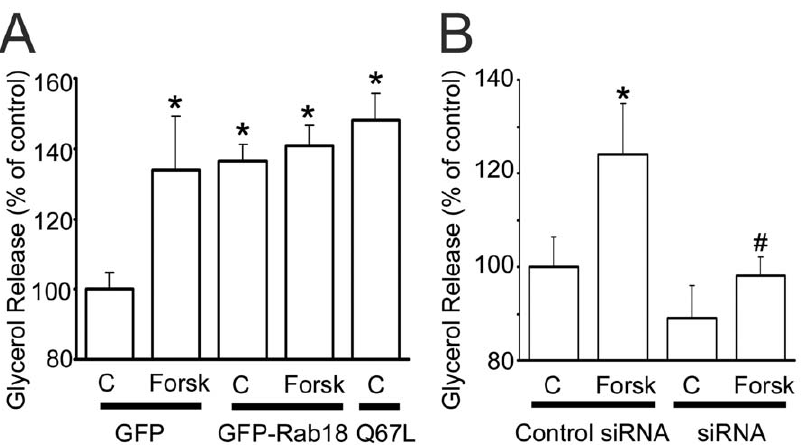
Figure 7. Effect of Rab18 overexpression and silencing on forskolin-induced lipolysis. (A) The effect of Rab18 overexpression on basal and forskolin-induced lipolysis was evaluated by transfecting 3T3-L1 adipocytes with GFP-tagged, wild-type Rab18 or the constitutively active mutant Rab18(Q67L) for 48–72 h. In each experiment, a group of cells (controls) were transfected a vector expressing GFP alone. GFP fluorescence served to confirm transfection efficiencies higher than 90% for each experiment prior to further experimental manipulation. After 30 min in the presence or absence of forskolin, the culture medium was collected and glycerol release measured with Free Glycerol Reagent kit (Sigma-Aldrich). Glycerol concentration in the medium was normalized to total protein and expressed as the mean 6 SEM of 5 independent experiments. (B) Rab18 silencing was achieved by transfecting 3T3-L1 cells with a mouse Rab18 specific siRNA. After 72 h, cells were challenged with 50 m M forskolin for 30 min. Glycerol release was quantified as indicated above and expressed as the mean 6 SEM of 5 independent experiments. *, P , 0.05 vs. untreated control cells. # , P , 0.05 vs. forskolin-treated control cells.